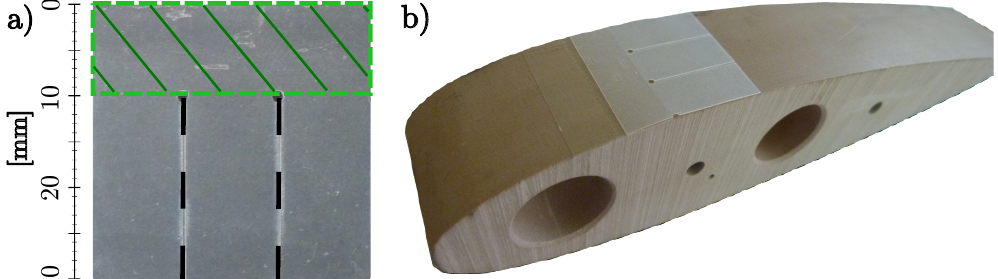
Figure 5. ( a ) Sample of the silicone flap material used in the experiment; the shaded area is used for taping; ( b ) visualization of the self-adaptive flaps on the NACA0020